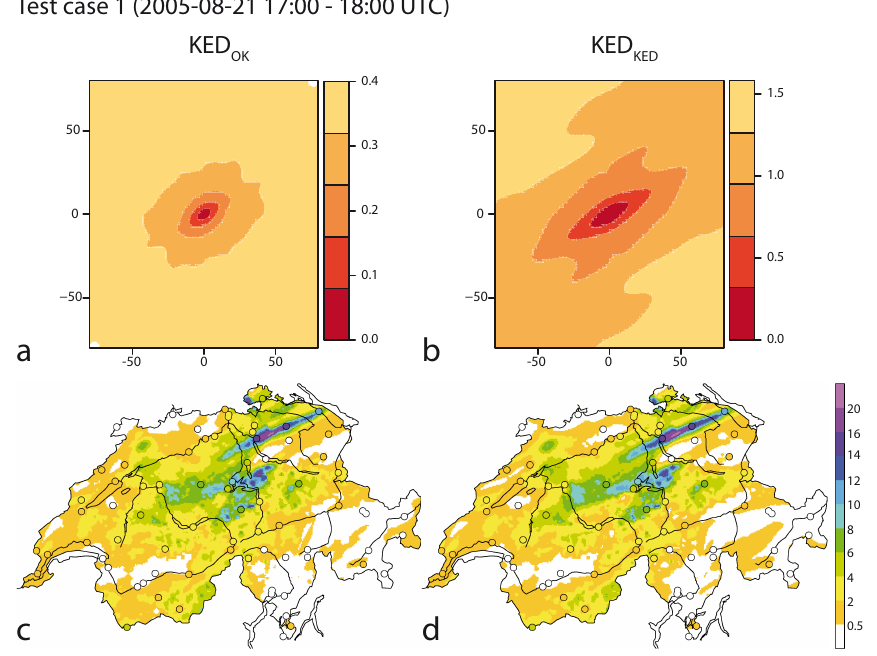
Fig. 7. Kriging with external drift for test case 1 (left: KED OK , right: KED KED ). (a) Nonparametric correlogram for KED OK expressend as a semivariogram (mm 2 ), (b) nonparametric correlogram for KED KED expressed as a semivariogram (mm 2 ), (c) KED OK prediction, (d) KED KED prediction (mm).